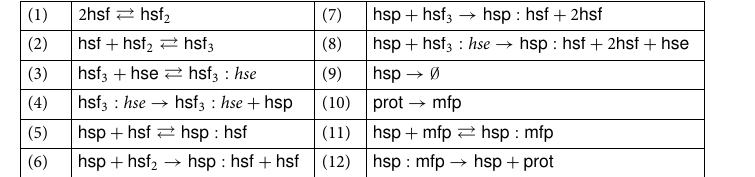
Table 4. The molecular model for the eukaryotic heat shock response proposed in 25